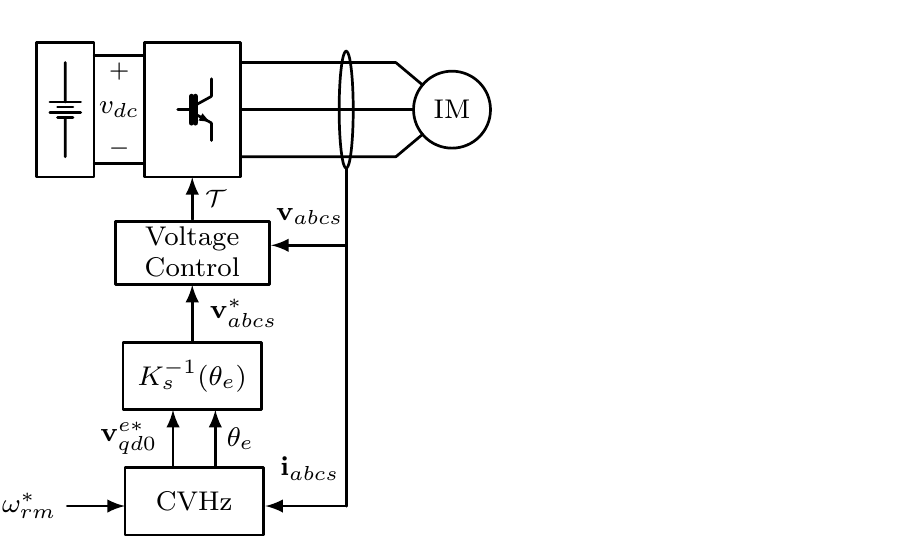
Figure 6. Compensated volts-per-hertz control drive block diagram.